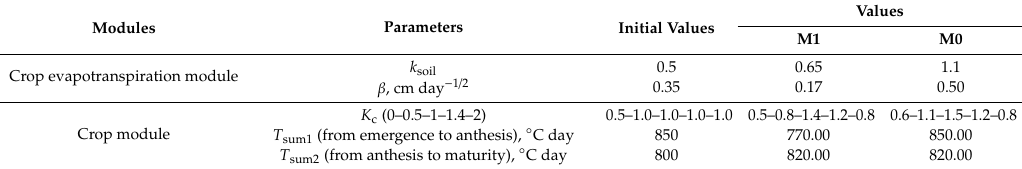
Table 4. Parameters under the conditions of film mulching (M1) and non-mulching (M0). Modules